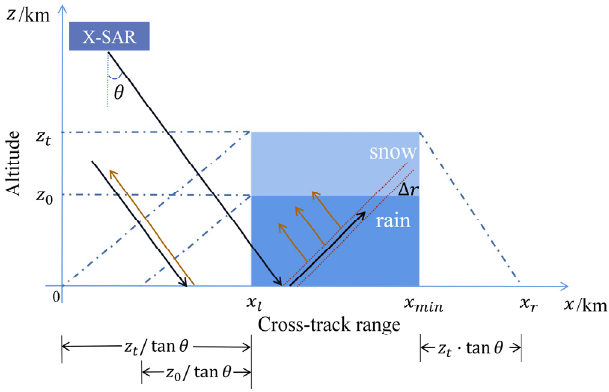
Figure 1. The cross - section of the two-layer precipitation model. Figure 1. The cross-section of the two-layer precipitation